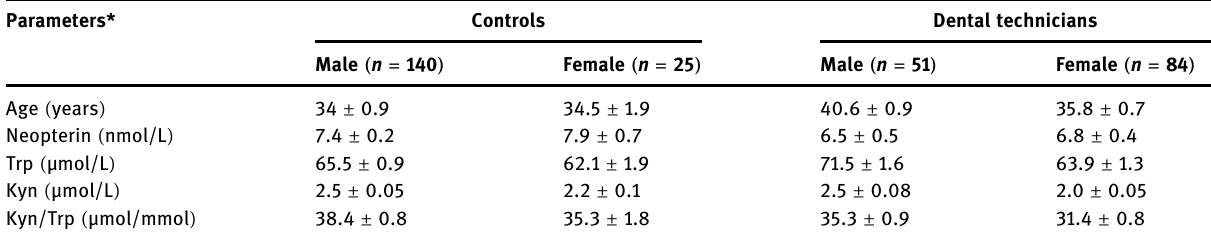
Table 2: Results of the measured parameters in gender subgroups Parameters* Controls